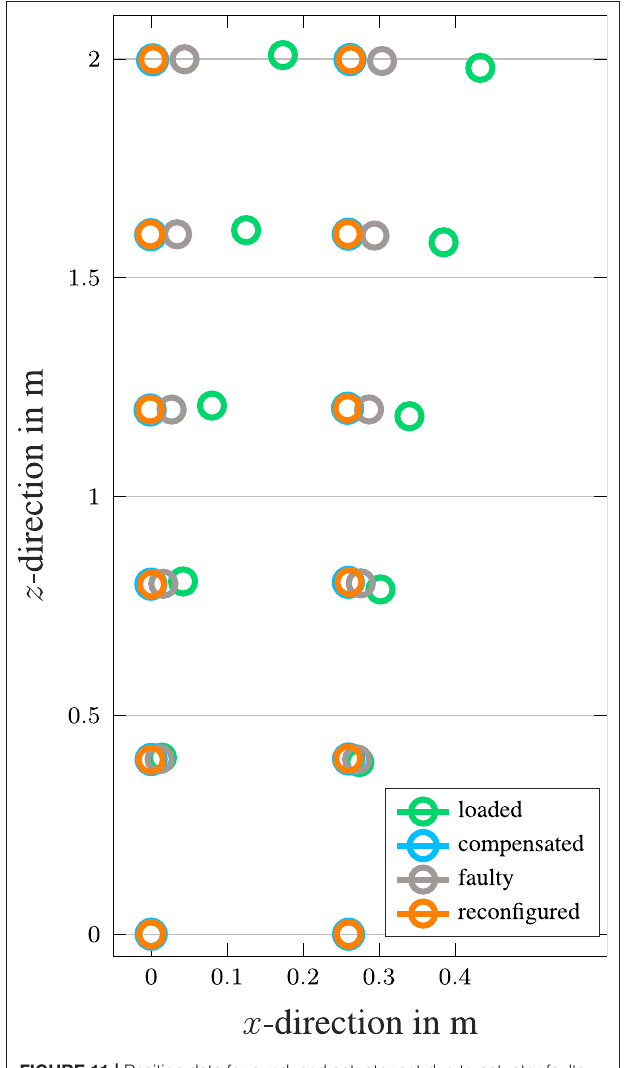
FIGURE 11 | Position data for a reduced actuator set due to actuator faults: the optimal input including all actuators (gray), the reconfigured optimal input for the reduced actuator set (orange), passive structure under load (green), and compensated state where all actuators are functional (light blue). The reduced actuator set does not include column actuator 3 and 4 due to actuator faults. The data is summarized in Table A1 (bottom) in the Appendix.